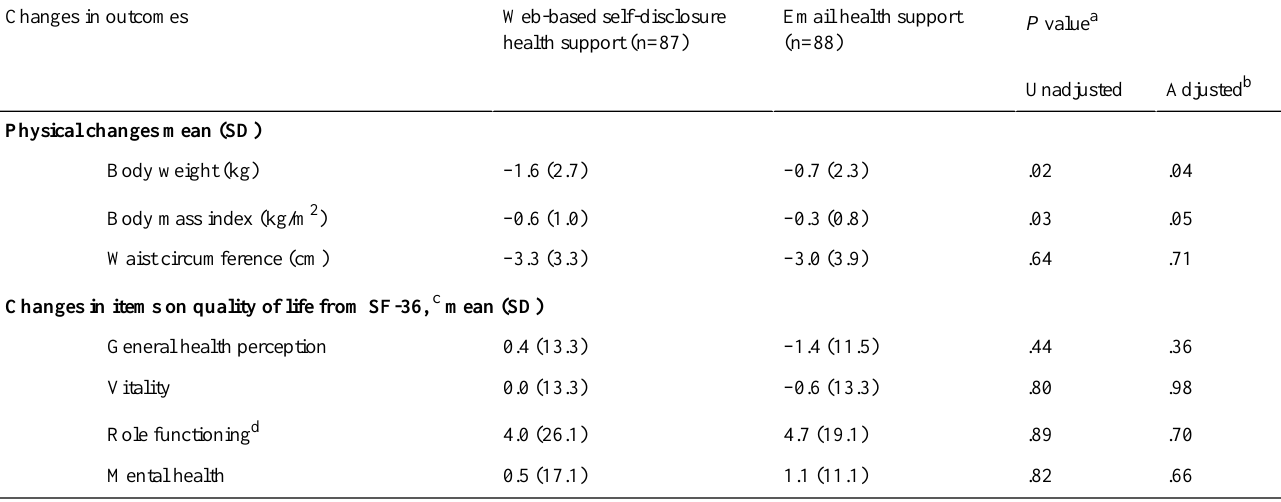
Table 2. Changes in physique and quality of life before and after intervention between groups